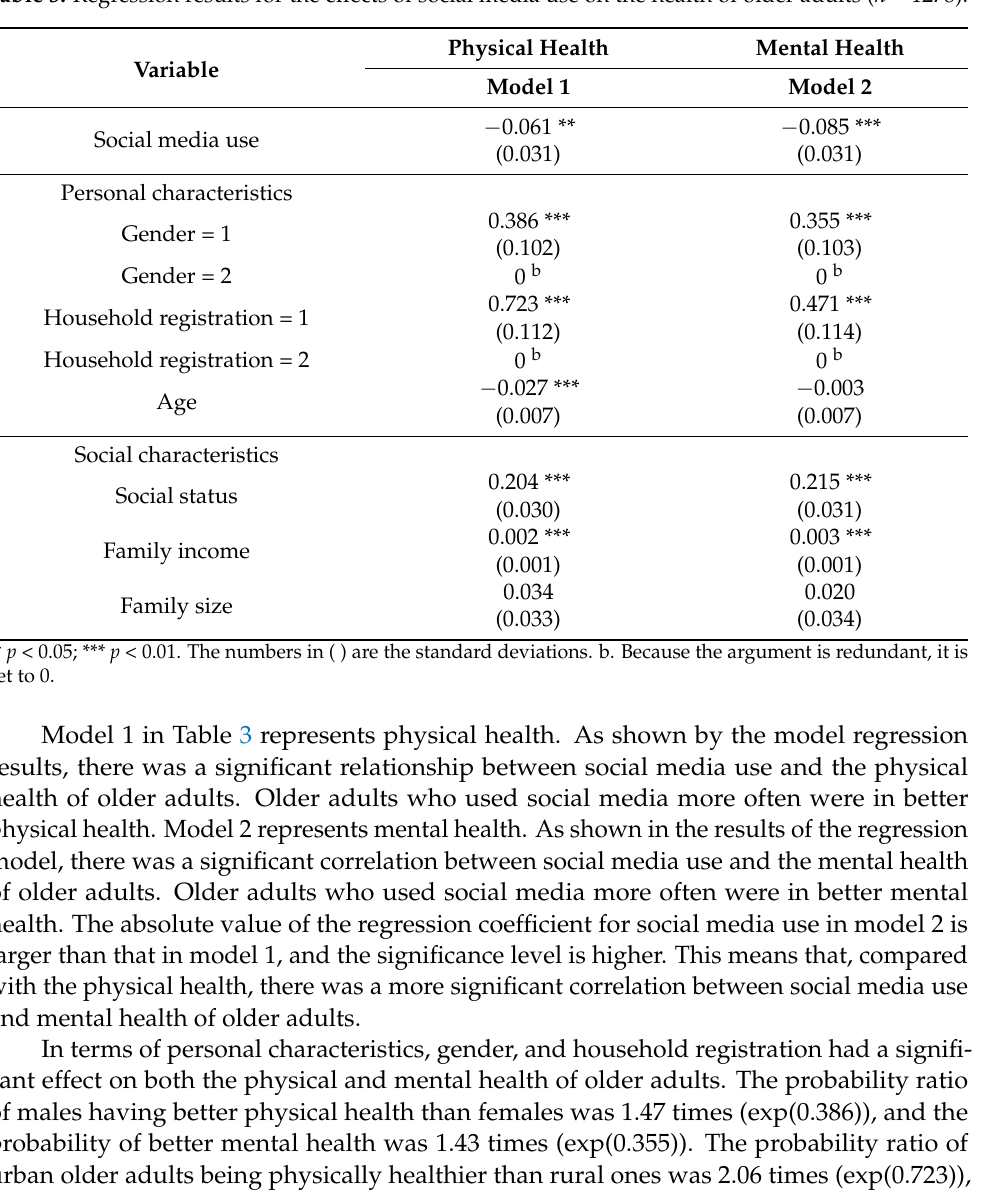
Table 3. Regression results for the effects of social media use on the health of older adults ( n =